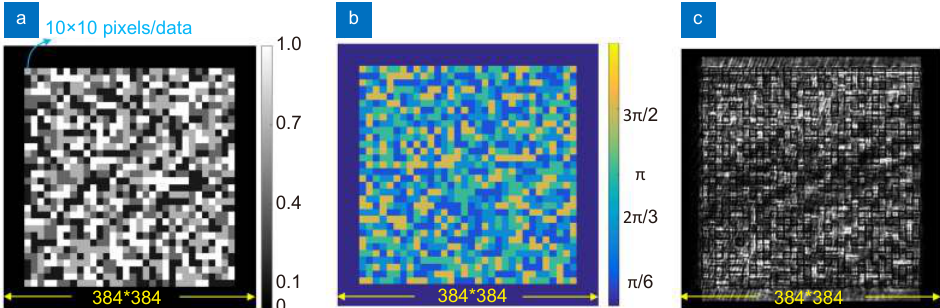
Fig. 10 | Complex-amplitude encoded data page and the intensity image captured by CMOS. ( a ) Data page uploaded on the amplitude SLM1. ( b ) Phase data page uploaded on the phase SLM2. ( c ) Diffraction intensity image captured by the CMOS at a diffraction distance of 2 mm.